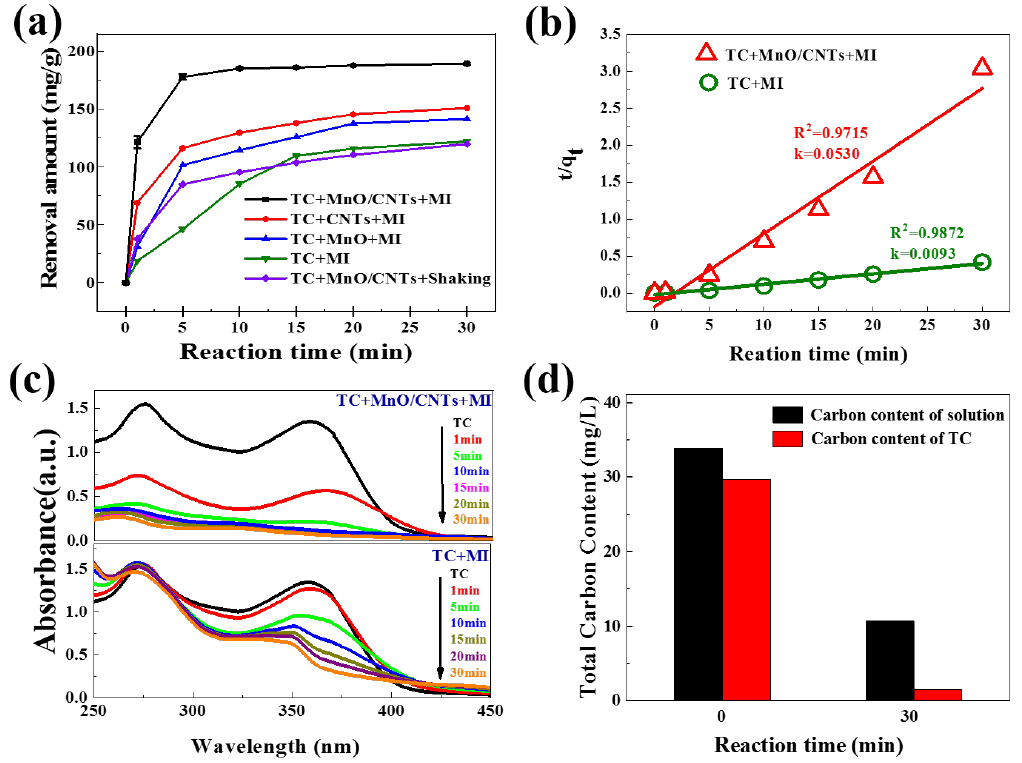
Figure 5. Removal of TC in the presence and absence of microwave and MnO/CNTs ( a ), pseudo- second-order degradation kinetic plots of TC ( b ), UV/Vis spectra of TC solution with/without MnO/CNTs after MI for different times ( c ), and and total carbon content with MnO/CNTs in the presence of the microwave ( d ).